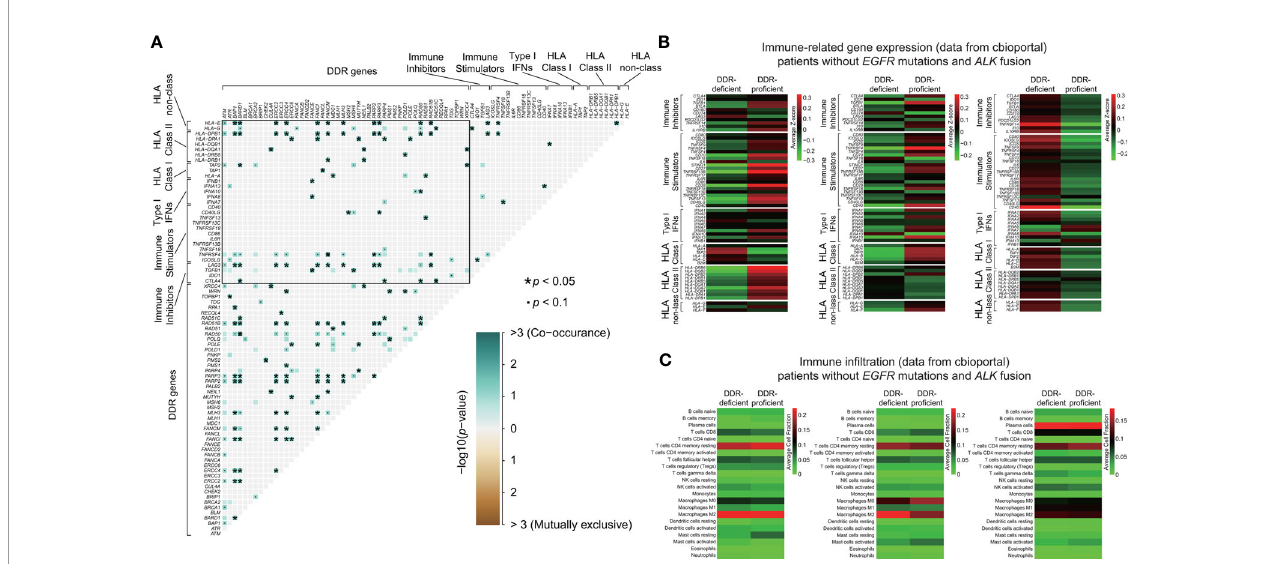
FIGURE 6 | Immune-related mechanisms of lung cancer patients without EGFR/ALK mutations between DDR-de fi cient and DDR-pro fi cient groups. (A) Somatic interactions of DDR genes and immunomodulatory genes. DDR genes were extensively comutated with immune genes and mutations in immune-related genes linked to speci fi c DDR gene alterations signi fi cantly. (B) The expression characteristics of immune-related genes between DDR-de fi cient and DDR-pro fi cient samples without EGFR or ALK mutations from cBioportal database. Samples were obtained from LADC-TCGA (n = 64), LUSC-TCGA (n = 72), and SCLC_ucologene_2015 (n = 79). (C) The immune microenvironment characteristics of lung cancer patients without EGFR mutations and ALK fusion from cBioportal database. Samples were obtained from LADC-TCGA (n = 64), LUSC-TCGA (n = 72), and SCLC_ucologene_2015 (n = 79). We used the R package “ maftools ” for the detection of co- occurring or mutually exclusive sets of genes and two-tailed Student ’ s test to compare immune-related gene expression between DDR-de fi cient and DDR-pro fi cient subtypes * p < 0.05. (cid:129) p <